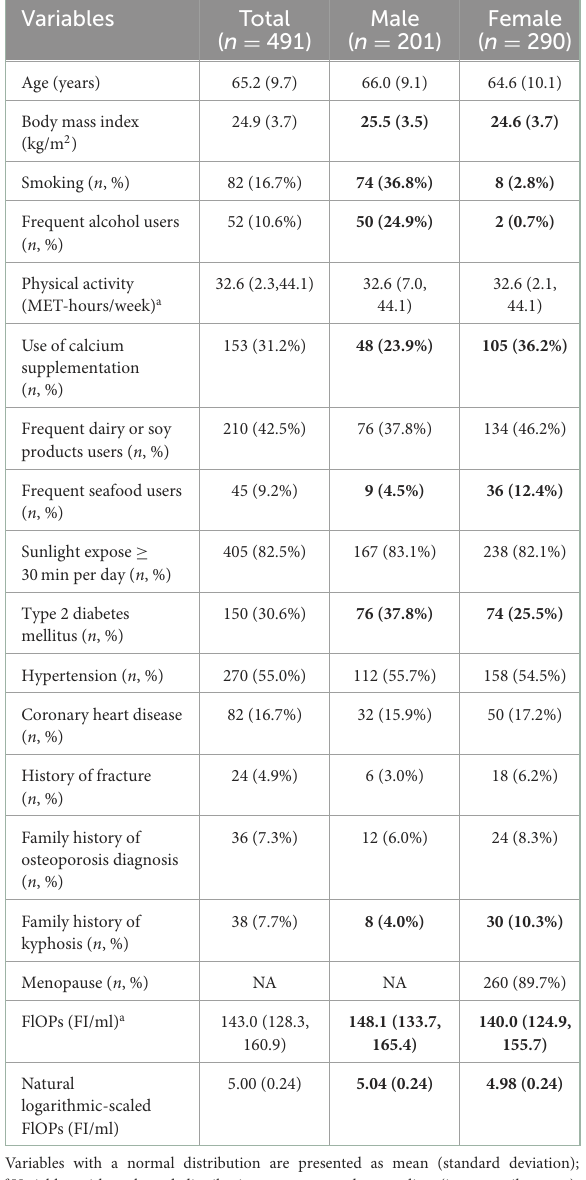
TABLE 1 Characteristics of the study